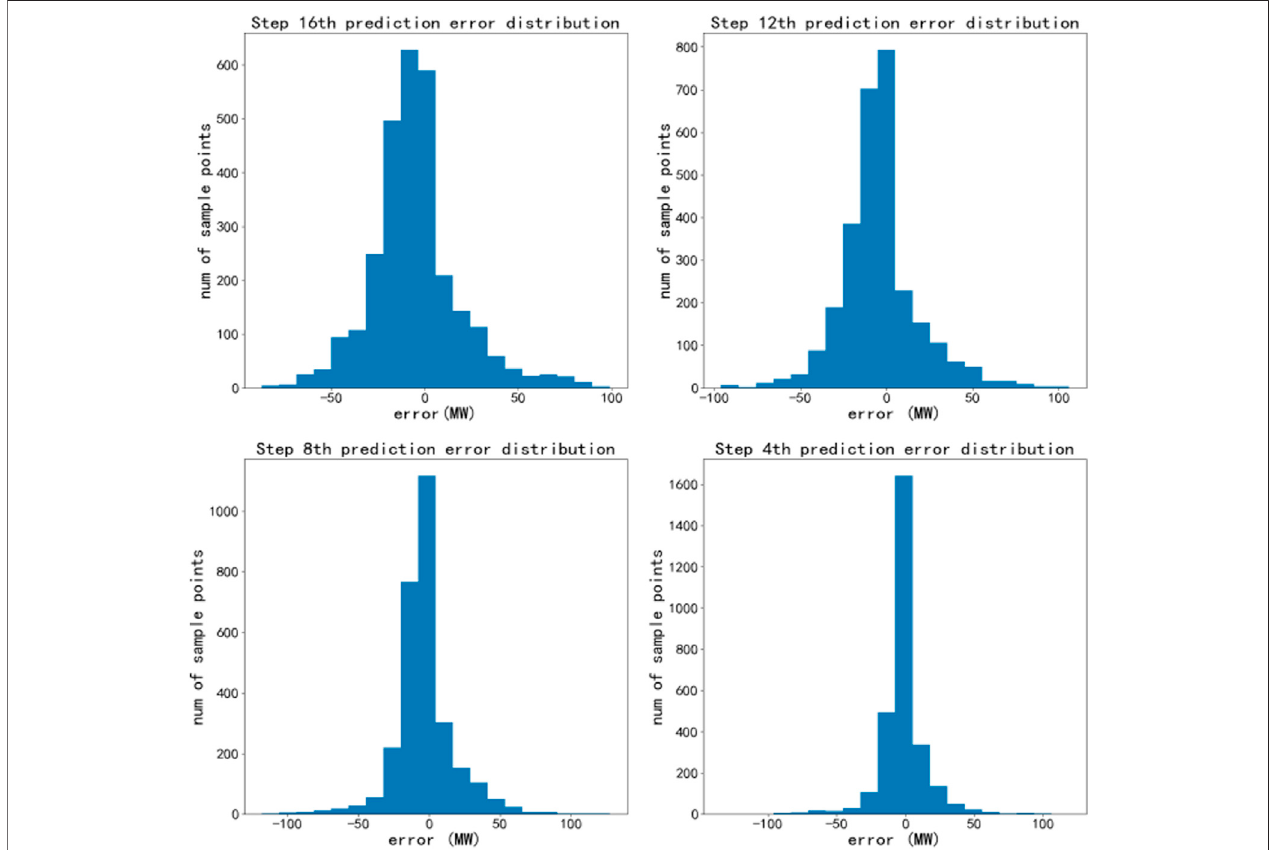
FIGURE 5 | Point prediction error